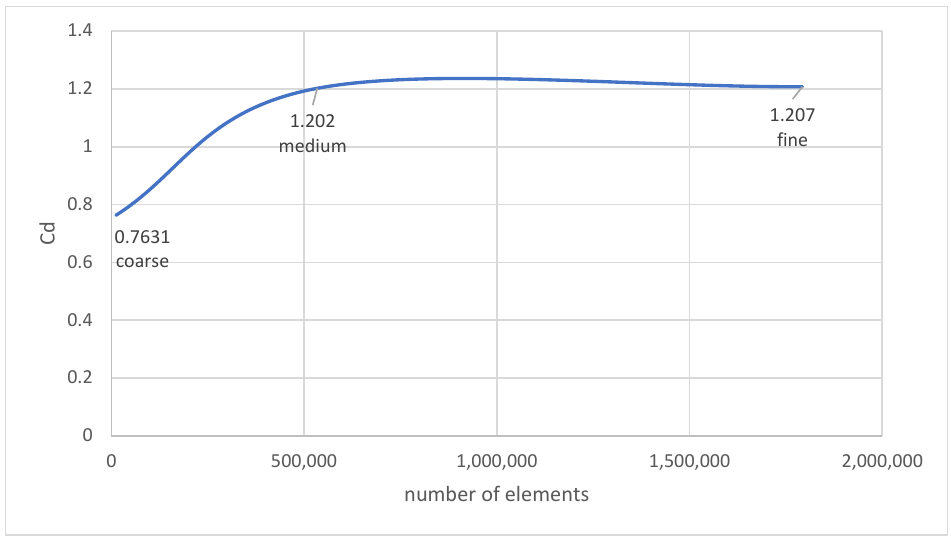
Figure 4. Drag coefficient (Cd) plot for coarse, medium, and fine meshes (three meshes).